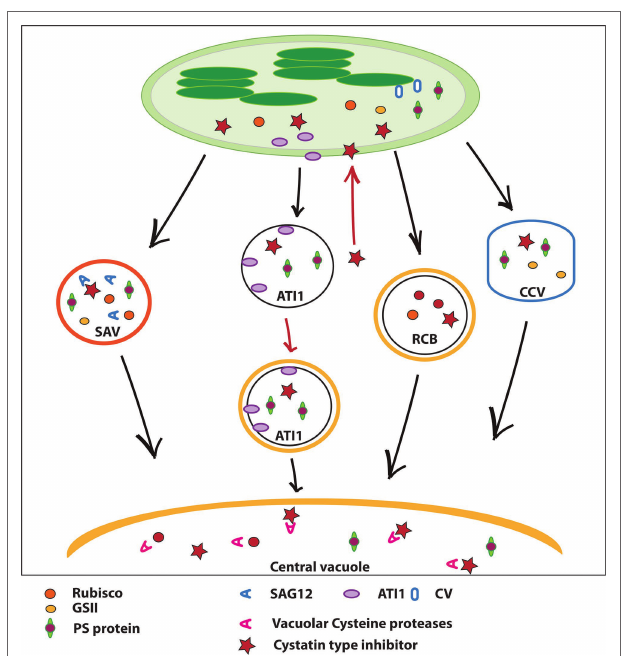
FIGURE 1 | A schematic representation of cellular pathways delivering chloroplast proteins to lytic compartments and a proposed strategy to inhibit plastid protein degradation in crop species. Chloroplast proteins traffic to “senescence-associated vacuoles” (SAVs) and/or to the central vacuole via “ATI1-plastid associated bodies” (ATI1-PS), “Rubisco-containing bodies” (RCBs), or “CV-containing vesicles” (CCVs). Each of these vesicles apparently transports specific proteins (Rubisco for SAVs and RCBs, certain thylakoid proteins for ATI1-PS and CCV), which may be degraded by cysteine proteases either in SAVs or the central vacuole. SAVs might also be internalized into the central vacuole, although this is hypothetical. A proposed strategy to reduce/slow down chloroplast protein degradation during senescence in crop plants is the use of targeted protease inhibitors. A proteinaceous protease inhibitor (e.g., a phytocystatin, or a Kunitz-type inhibitor such as WSCP, represented by a red star in the cytosol) fused to a chloroplast transit peptide is expressed under control of a senescence- induced promoter. The chloroplast-located inhibitor would then be redirected to RCBs, ATI1-PS, CCV, and/or SAVs by the same mechanism which directs chloroplast-targeted fluorescent proteins to these vesicular structures. Once in the central vacuole or in SAVs, the inhibitor binds proteases, thus reducing proteolytic activity and preserving protein